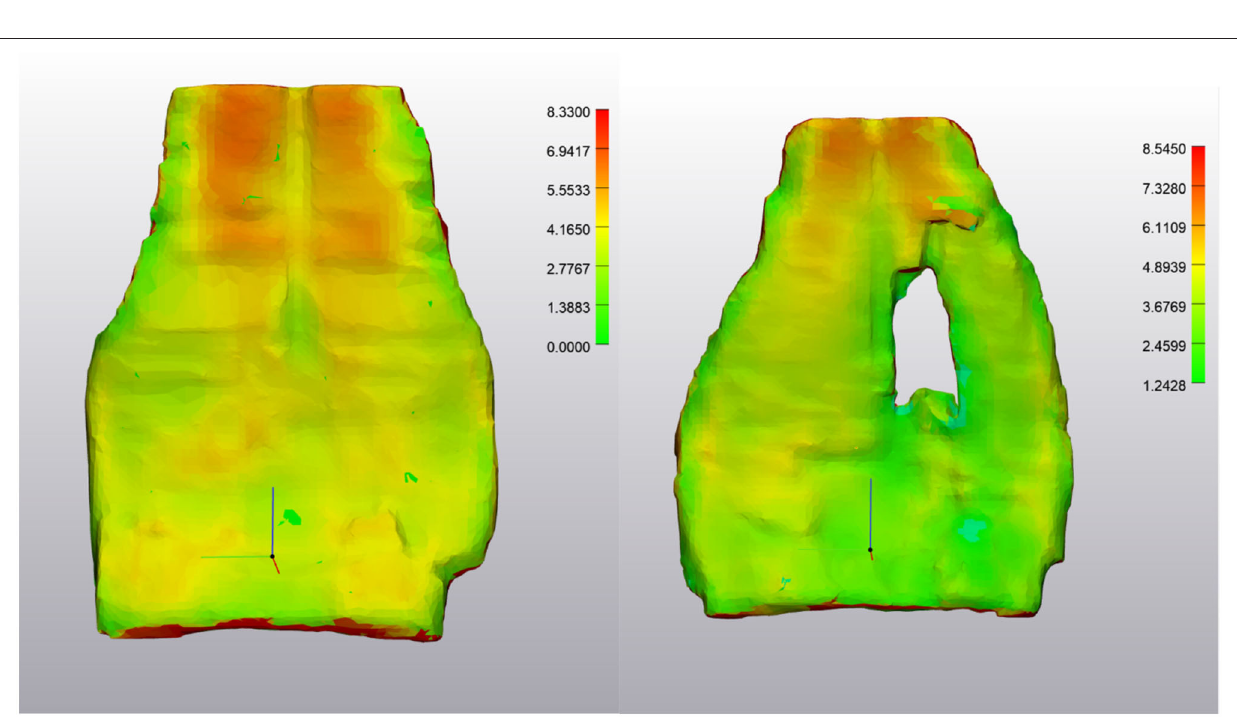
Frontiers in Veterinary Science |